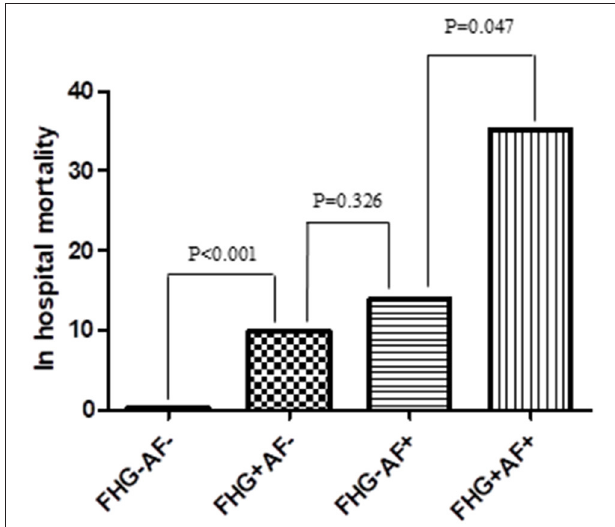
FIGURE 3 | Comparison of in hospital mortality among groups. FHG + AF– group showed higher rate of in hospital mortality compared with FHG–AF– group (9.7 vs. 0.3%, P < 0.001). In hospital mortality was higher in FHG + AF + group compared with FHG–AF + group (35.2 vs. 13.8%, P = 0.047), while there was no difference between FHG + AF– and FHG–AF + group (9.7 vs. 13.8%, P = 0.326). FHG–AF–, patients with neither fasting hyperglycemia nor new-onset atrial fibrillation; FHG + AF– patients with fasting hyperglycemia but without new-onset atrial fibrillation; FG–AF + , patients with new-onset